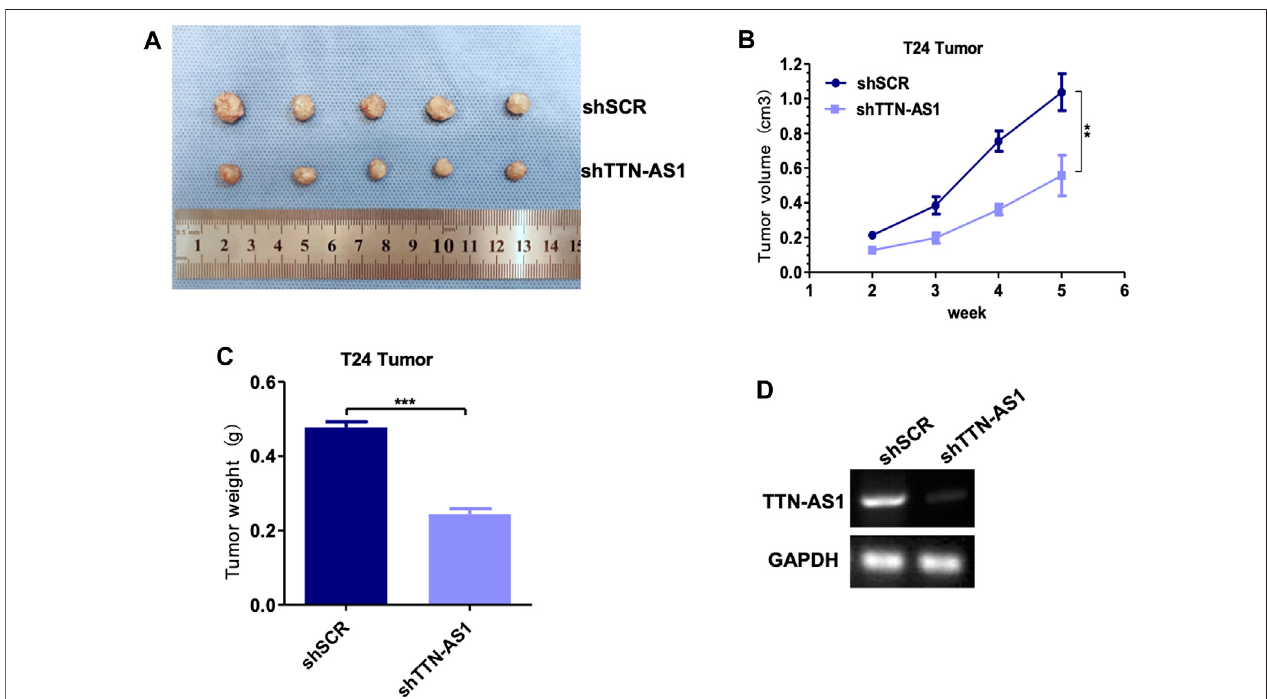
FIGURE 3 | Knocking down lncRNA TTN-AS1 inhibits the growth of bladder tumors in vivo . (A) The tumor size and morphology were compared between shSCR andshTTN-AS1groups. (B) ThetumorvolumewasanalyzedinbothshSCRandshTTN-AS1groups. (C) Thetumorweightwasplottedonagraph(**means: p < 0.001). (D) qRT-PCR was used to detect the expression level of lncRNA TTN-AS1 at mRNA level from the tumor in both shSCR and shTTN-AS1